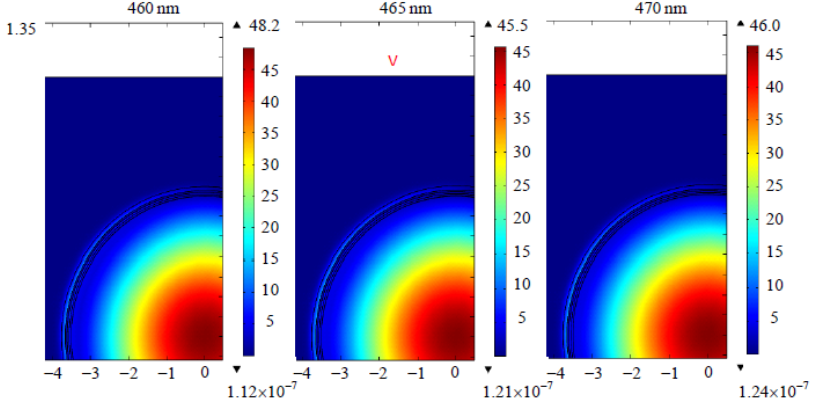
Fig. 8 Electric field intensity distributions with the refractive index are 1.31, 1.33, and